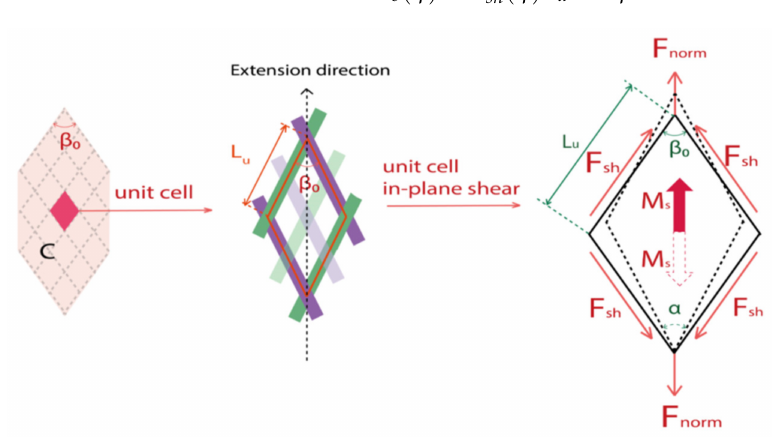
Figure 4. Shear load and shear moment on the unit